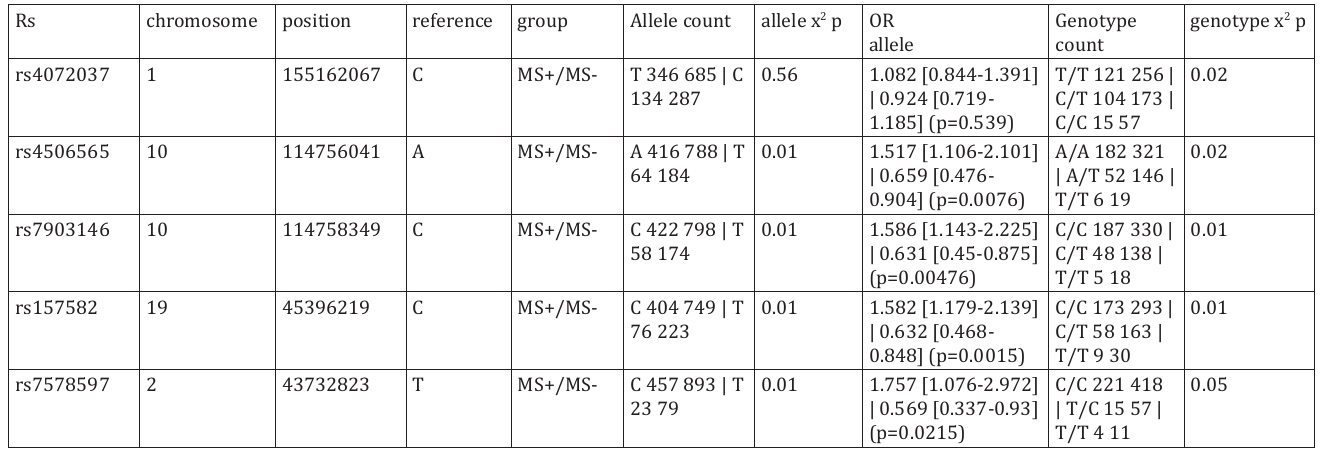
Comparative assessment of differences in alleles and genotypes in groups with and without MS